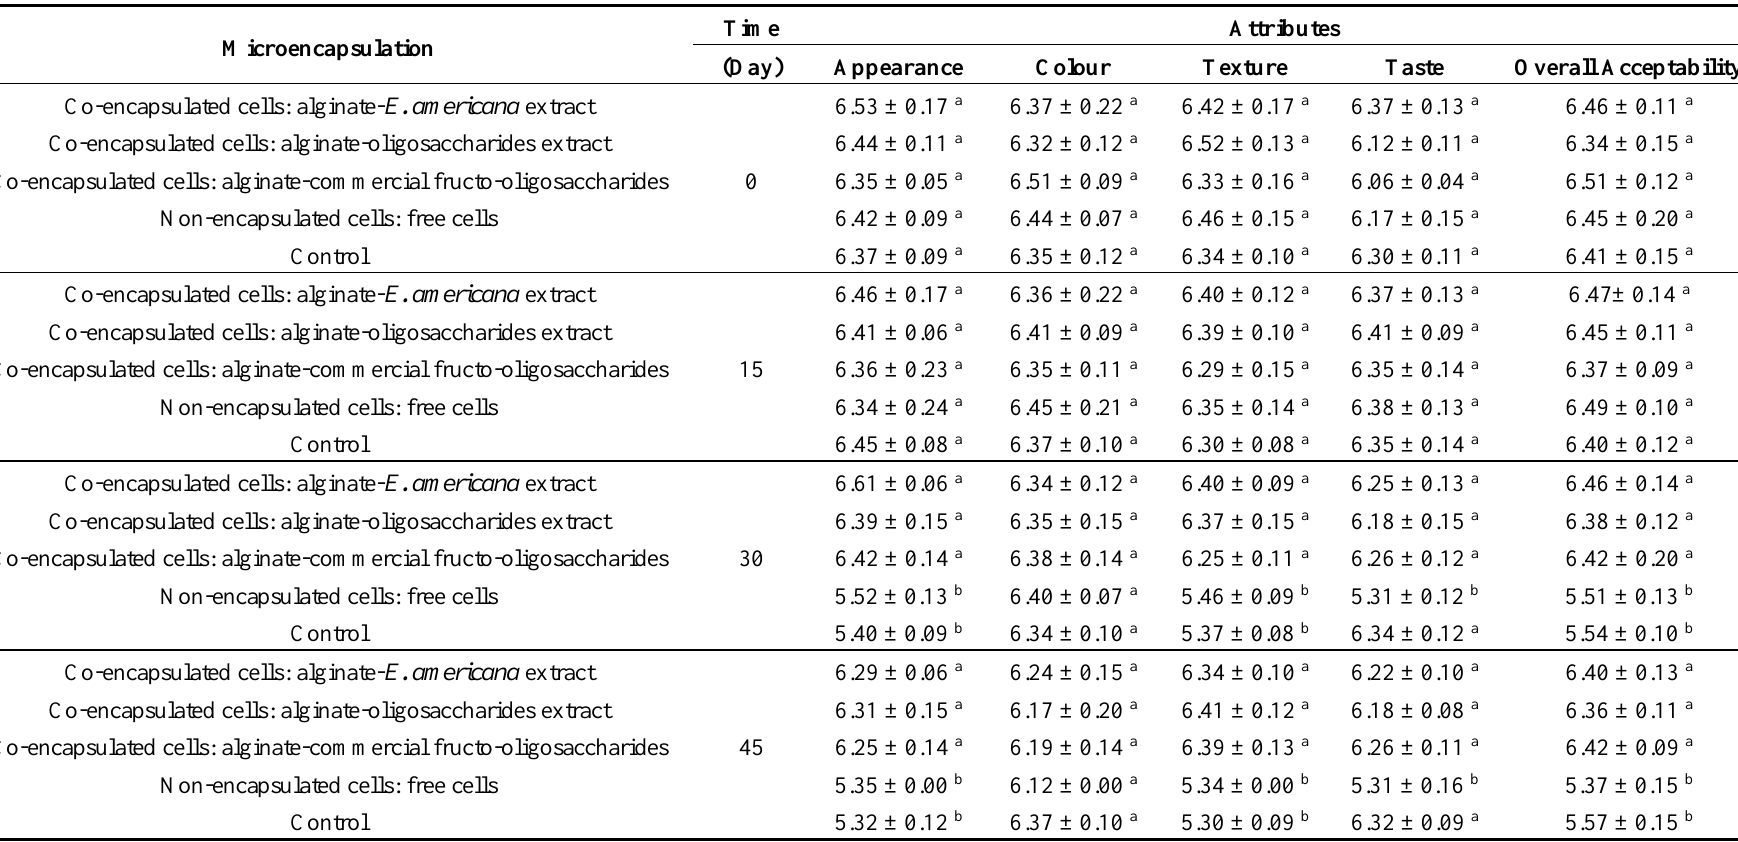
Table 4. Sensory scores of pineapple juice supplemented with microencapsulated Bifidobacterium longum with Eleutherine americana during refrigeration